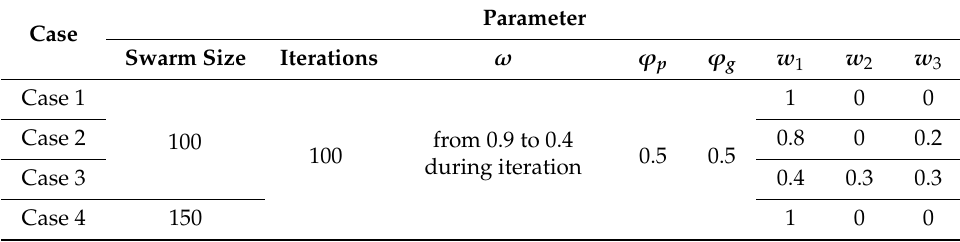
Table 1. The PSO algorithm parameter and weighting values of the four test